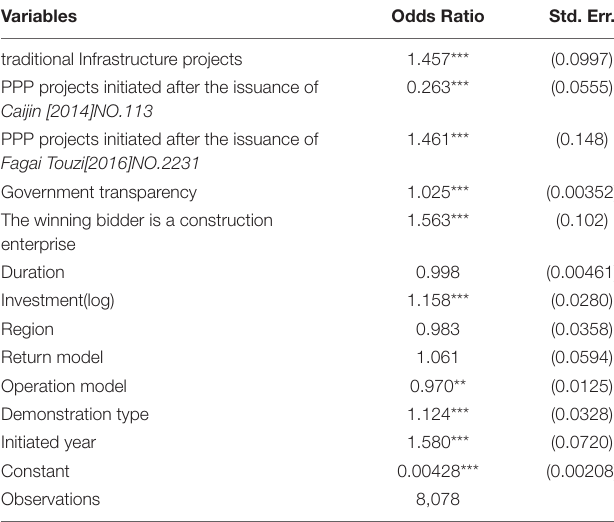
TABLE 4 | Baseline regression